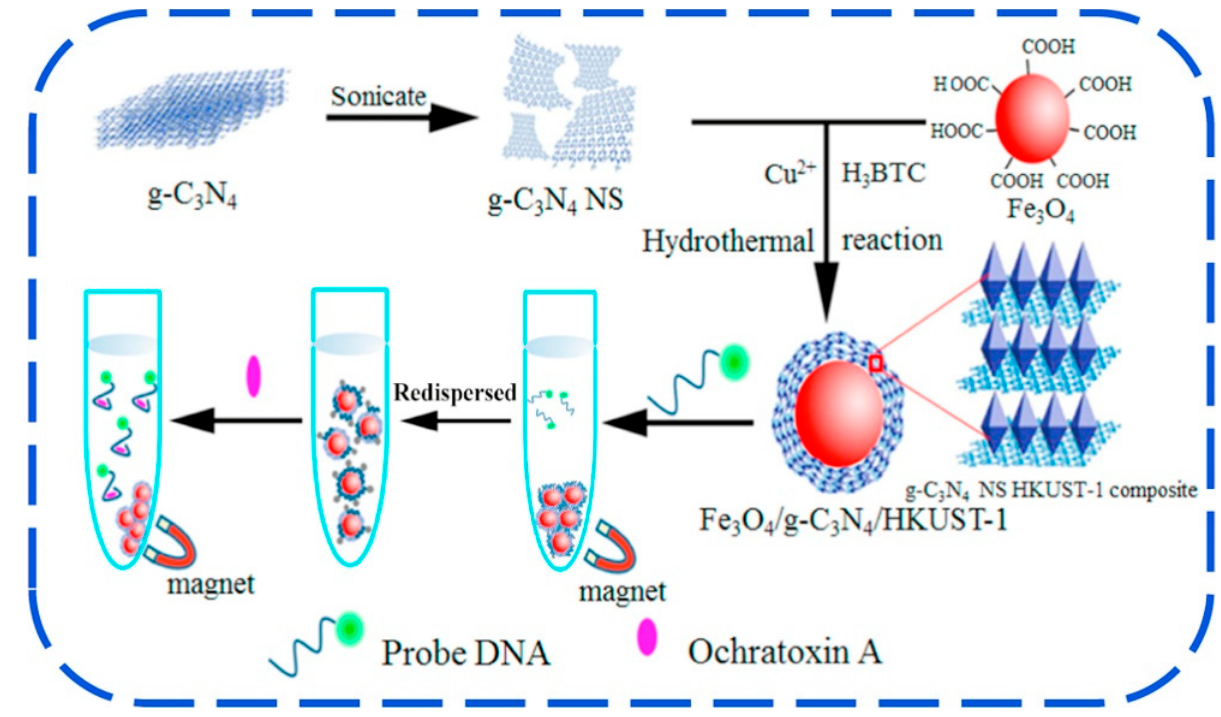
Figure 7. Schematic diagram representing principle of the biosensor based on Fe 3 O 4 /g-C 3 N 4 /HKUST-1 to detect OTA [199]. Copyright permission has been